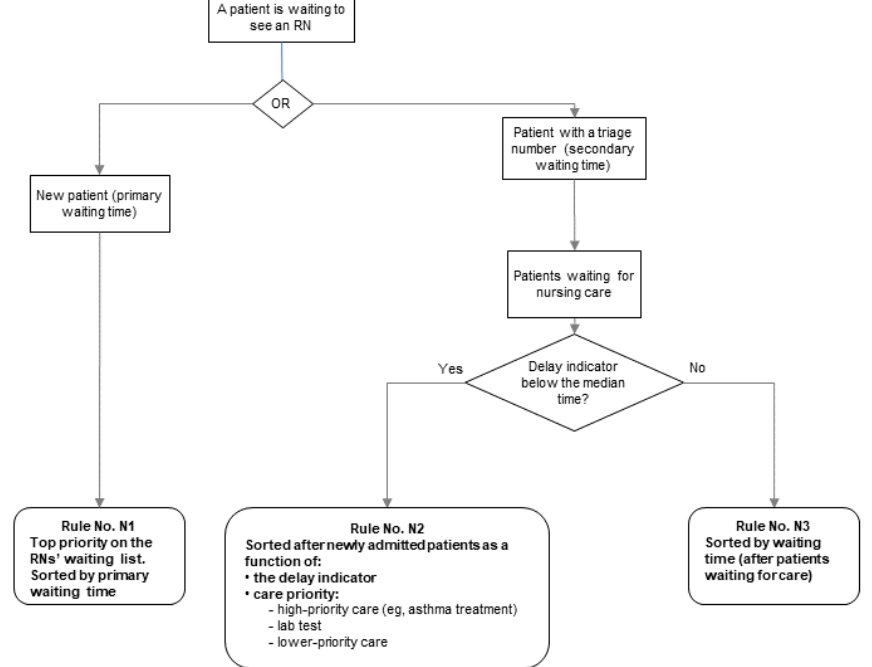
Figure 6. Sorting rules for the registered nurses, as integrated into the patient prioritization algorithm. Patients with life-threatening medical emergencies are always considered the highest priority and therefore do not appear in these sorting rules. RN: registered